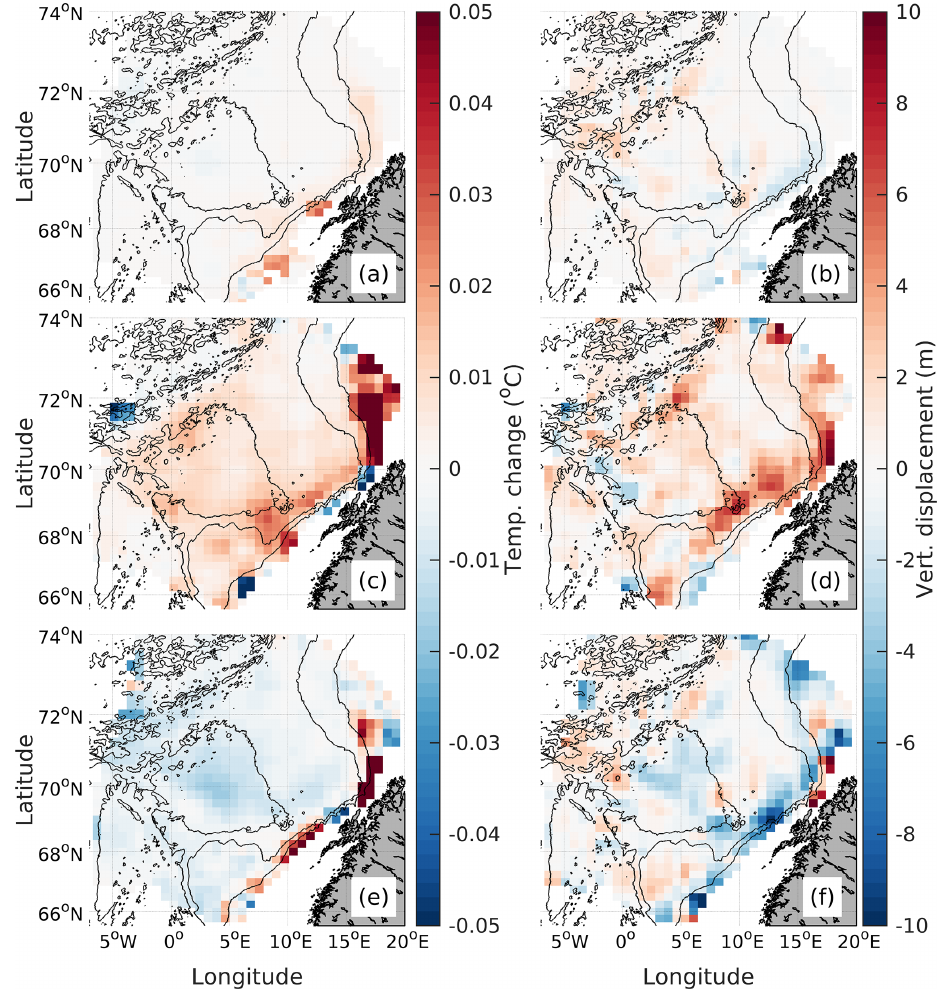
Figure 11. As in Fig. 10 but for 3D drifters deployed at